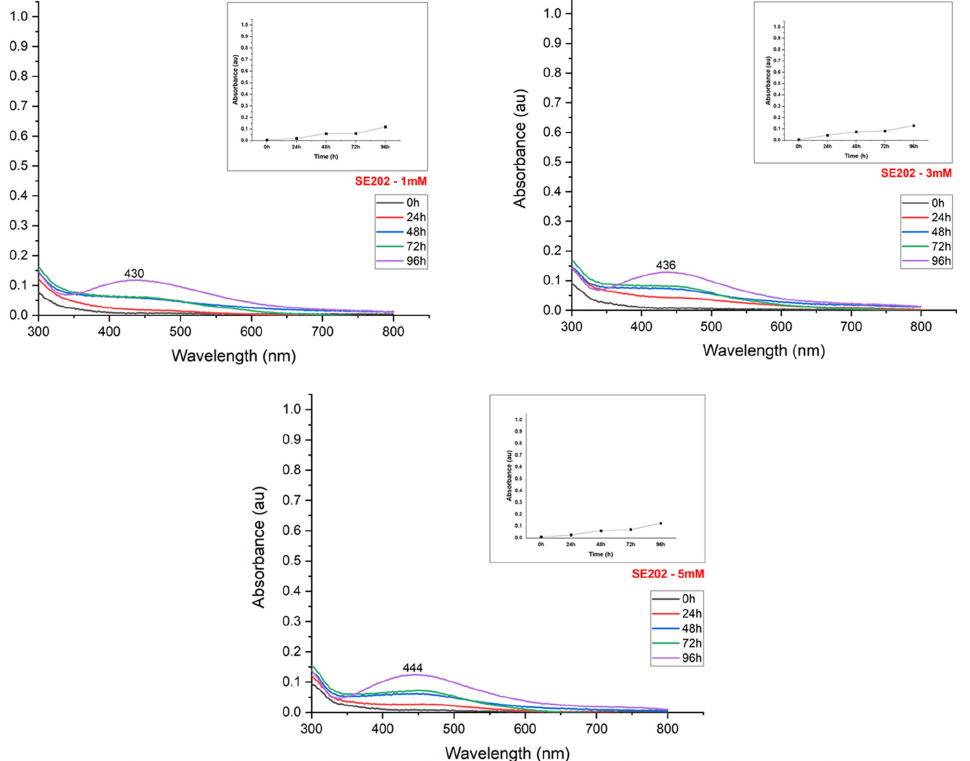
Figure 5. UV-Visible absorption spectrum of the evaluation of the effect of silver nitrate concentration on the synthesis of silver nanoparticles using an extract of the fungus M. anisopliae (isolate SE202).